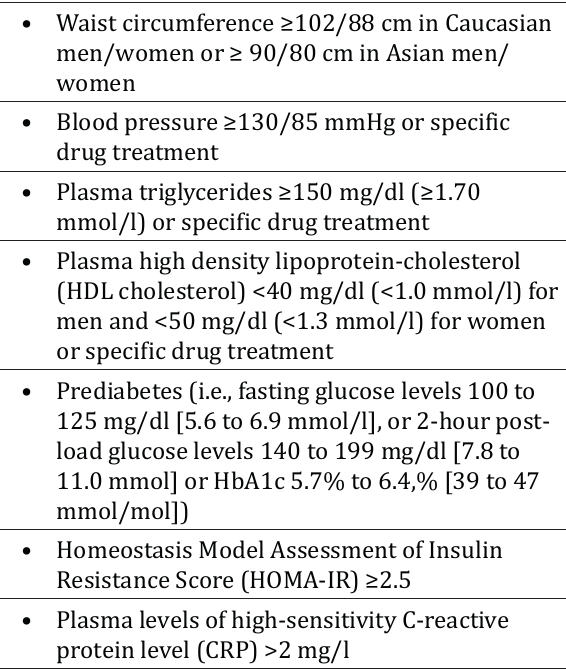
• Waist circumference ≥102/88 cm in Caucasian men/women or ≥ 90/80 cm in Asian men/